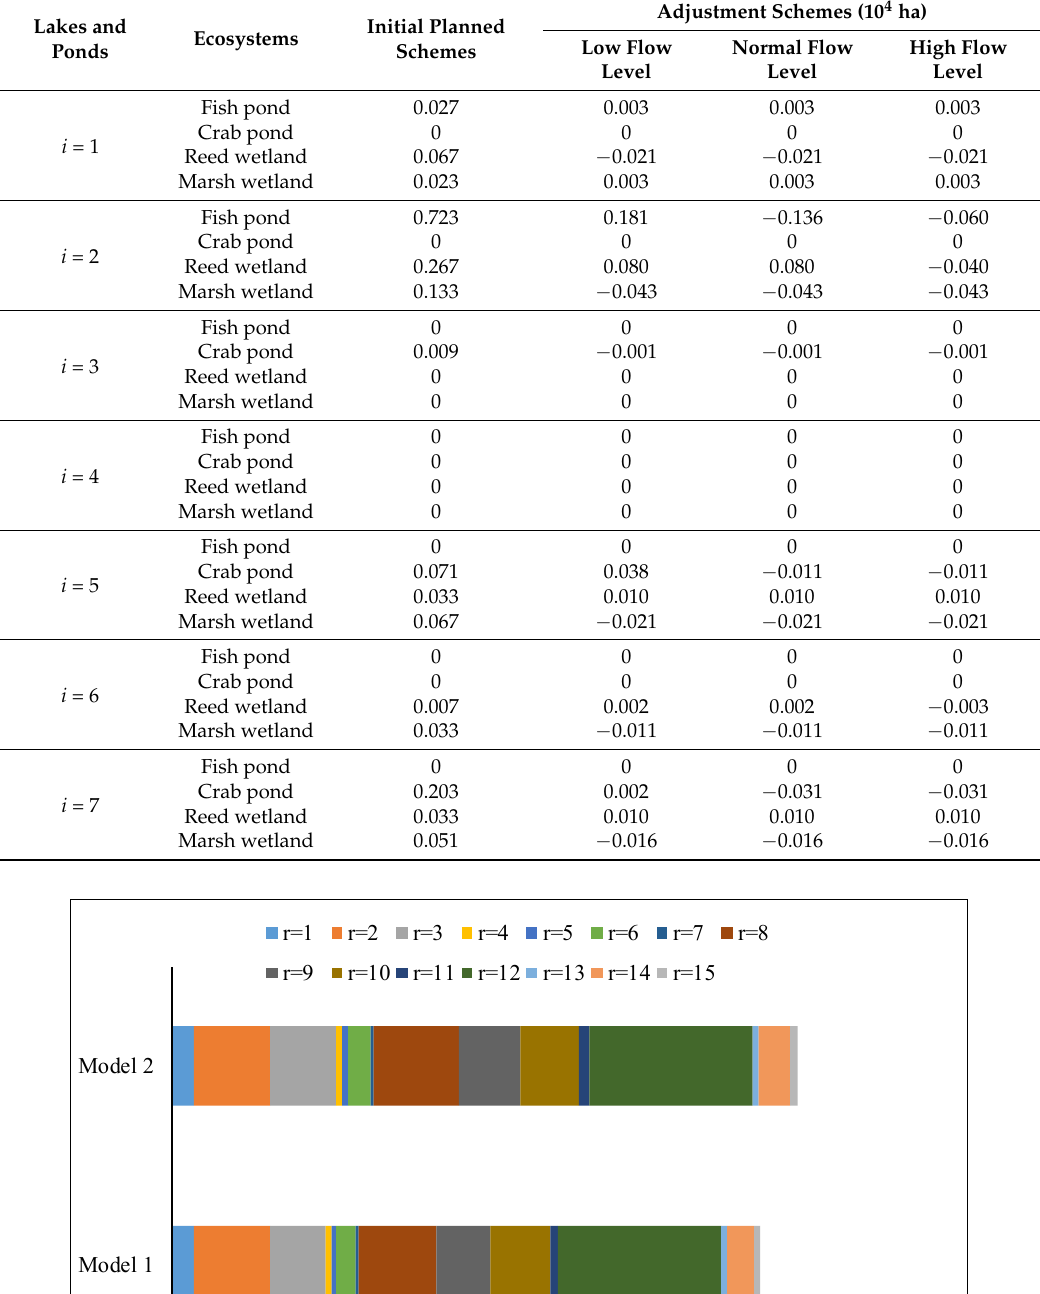
Table 8. Adjustments to the original ecosystem restoration schemes of lakes and ponds in western Jilin Province (Nong’an County in the Songhua River basin, for example).